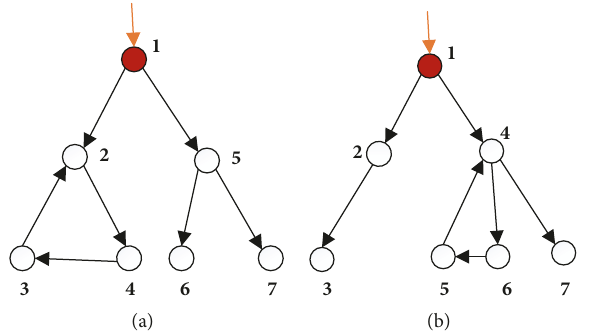
Figure 1: There are two simple networks of 𝑁 = 7 nodes with different structures. The controlled network has an input node connecting to state node 𝑥 1